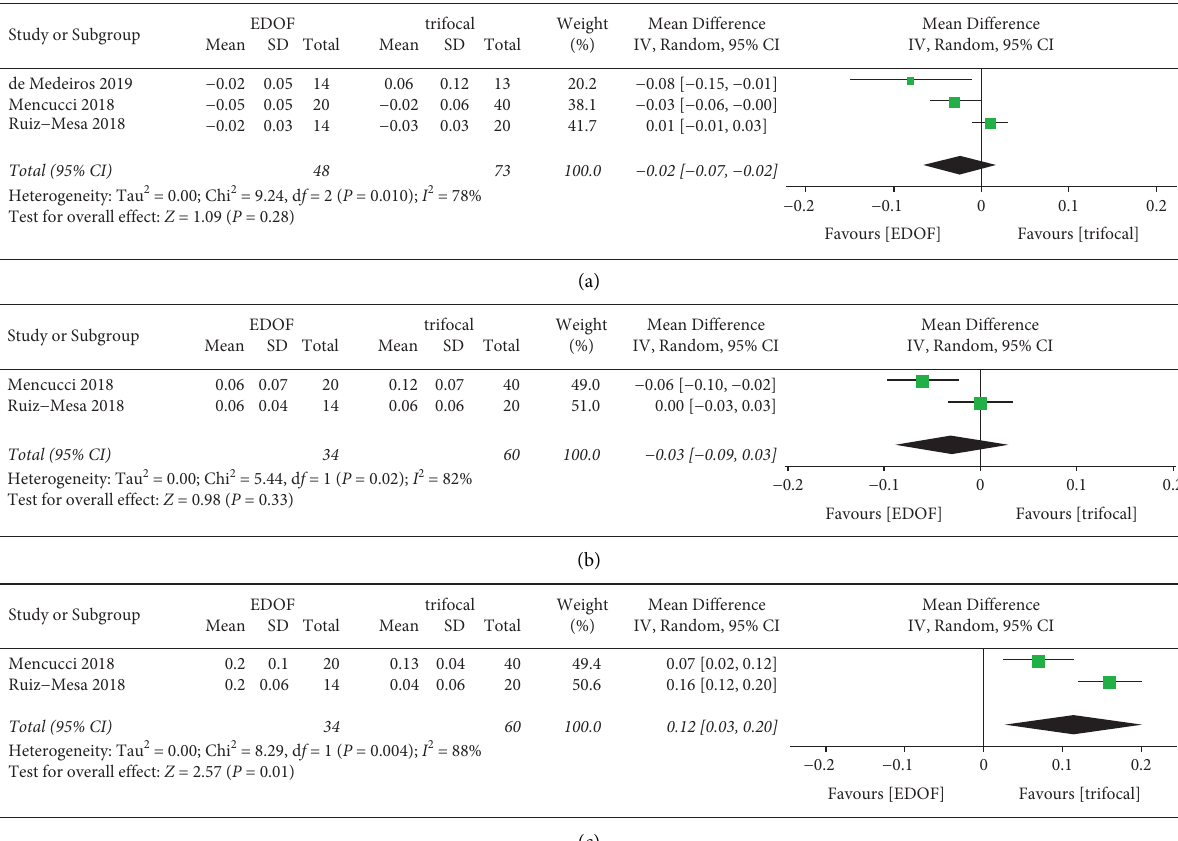
Figure 8: Forest plot of binocular corrected visual acuity. (a) Corrected distance visual acuity; (b) distance corrected intermediate visual acuity; and (c) distance corrected near visual acuity. EDOF, extended depth-of-focus; SD, standard deviation; CI, confidence interval; IV, inverse